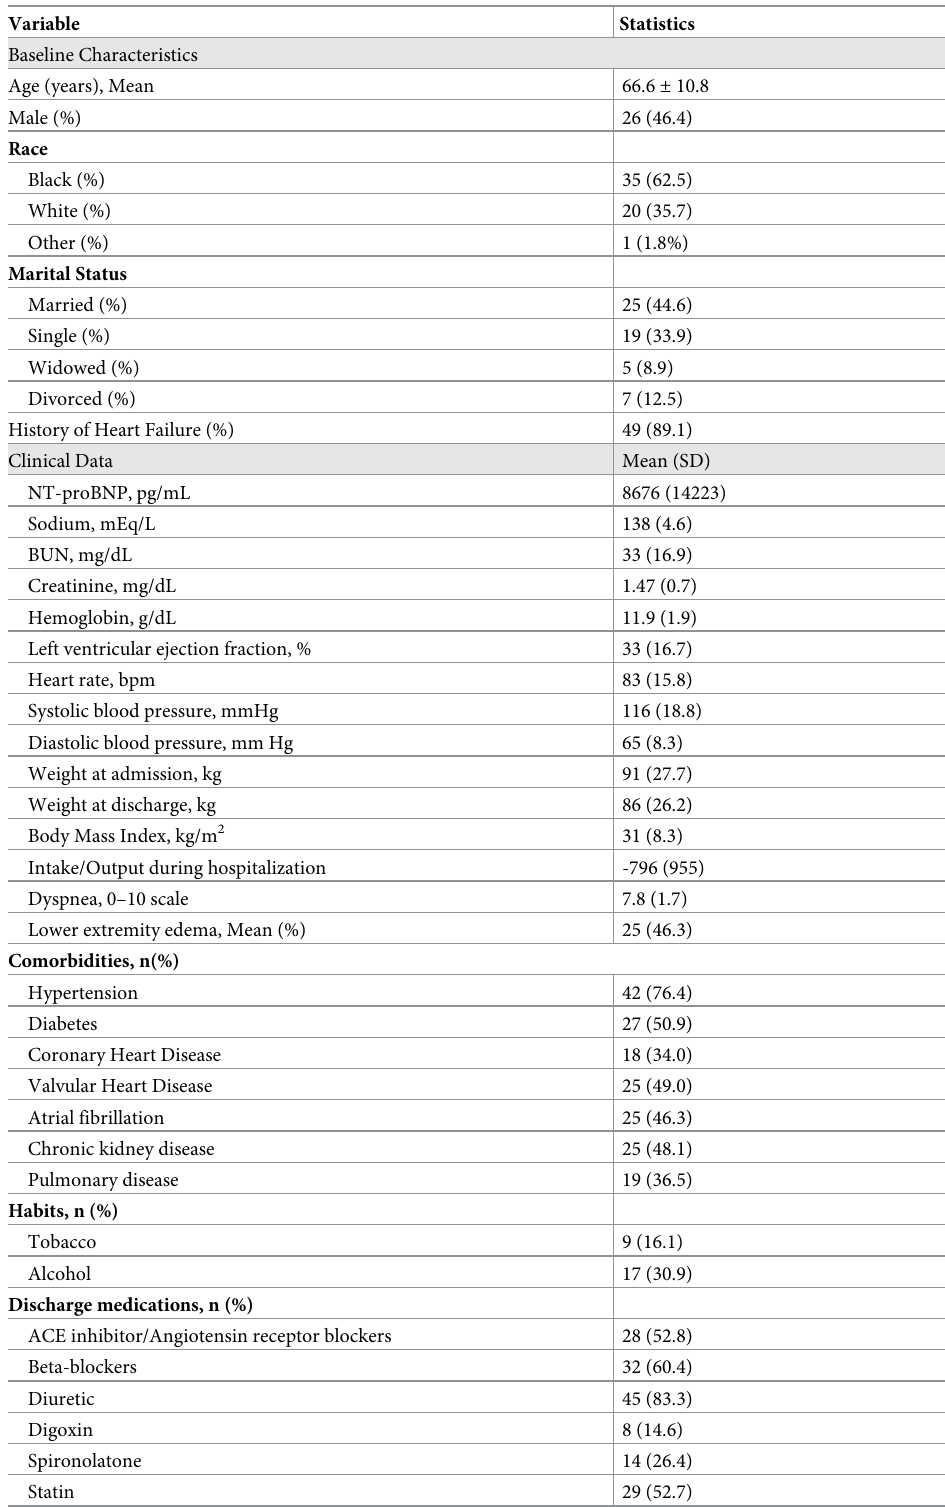
Table 1. Participant characteristics (n =